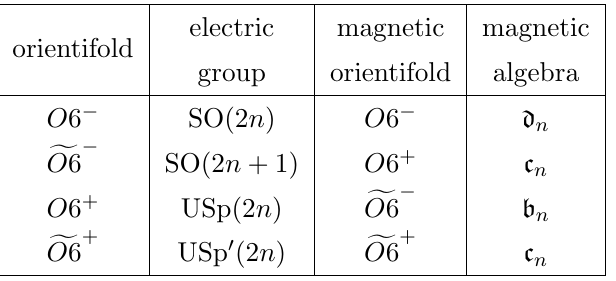
Table 4 . The two left columns display low-energy gauge group of a stack of n physical D6 branes on top of an O6 plane, all suspended in between NS5 branes. The two columns on the right-hand-side display the proposed magnetic orientifold to read o(cid:11) the magnetic gauge algebra of a stack of n physical D6 on top of an magnetic orientifold, all suspended between D8